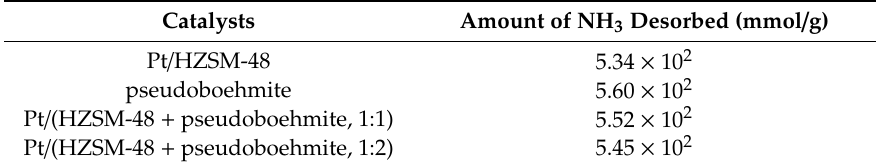
Figure 6. NH 3 -TPD of various catalysts ( a ) Pt / HZSM-48, ( b ) Pt / (HZSM-48 + pseudoboehmite, 1:1), ( c ) Pt / (HZSM-48 + pseudoboehmite, 1:2), ( d ) pseudoboehmite (calcined at 400 ◦ C). Table 2. Amount of NH 3 desorbed during NH 3 -TPD on various catalysts.